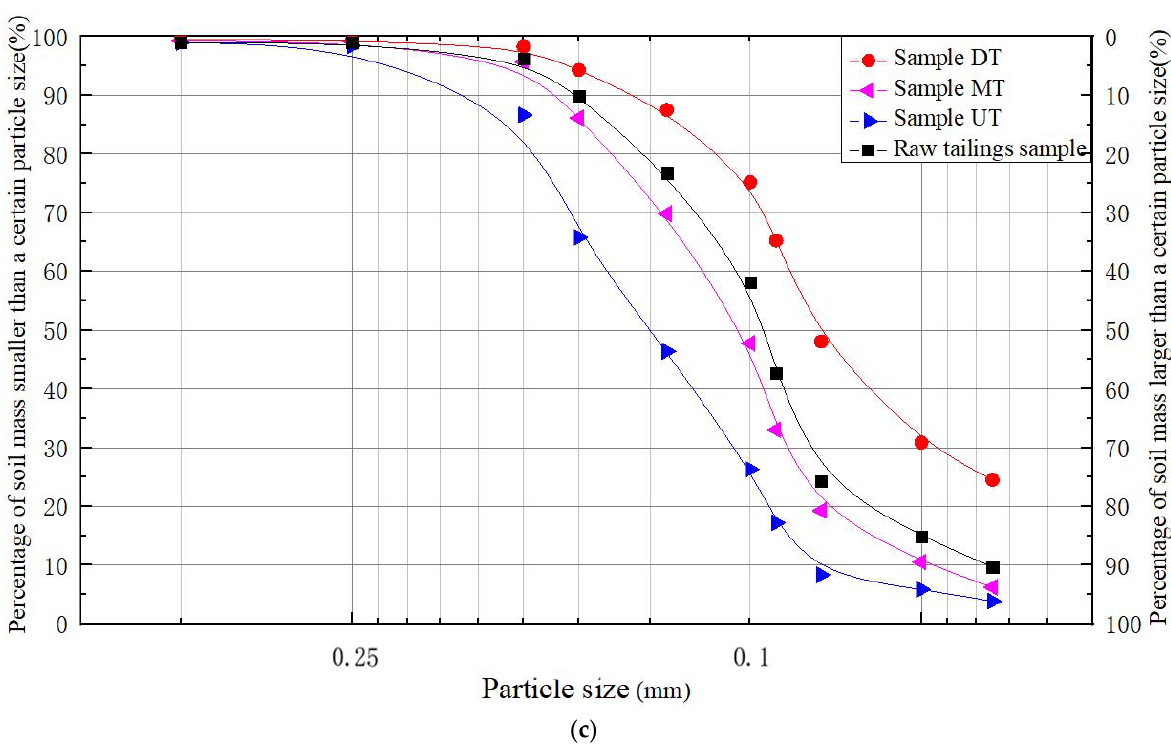
Figure 5. Particle size distribution curves of sedimentary tailings samples at different slopes. ( a ) 1% slope. ( b ) 1.5% slope. ( c ) 2% slope.